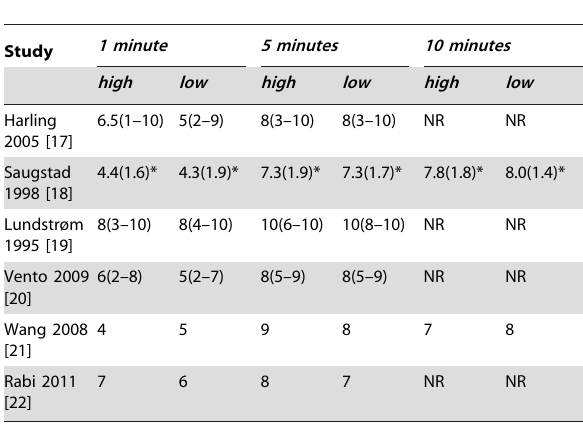
Table 5. Apgar scores (time after birth): median and inter- quartile range (if available). Table 6. Neonatal morbidity